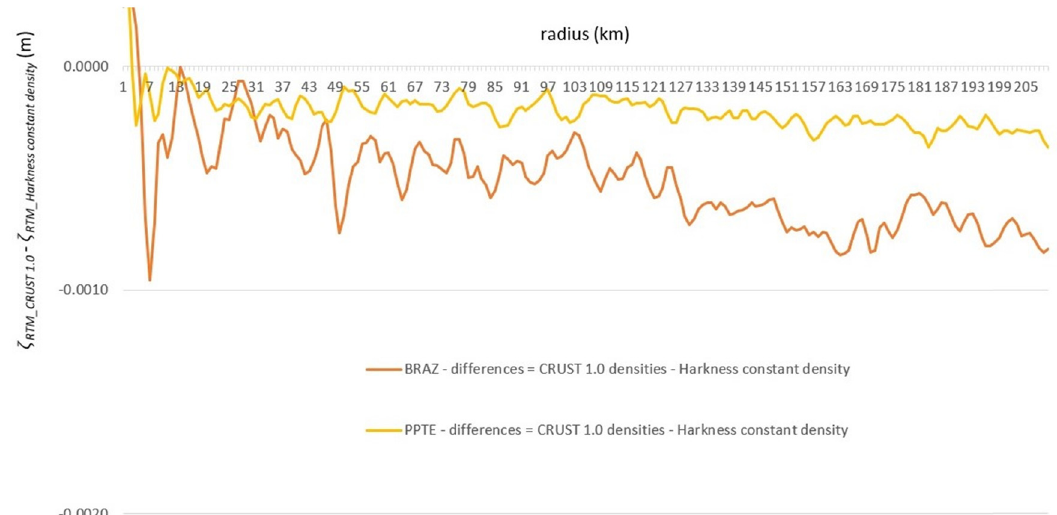
Figure 10: Di ff erences between RTM height anomalies using CRUST 1.0 densities and Harkness constant density value, using tesseroid approach as